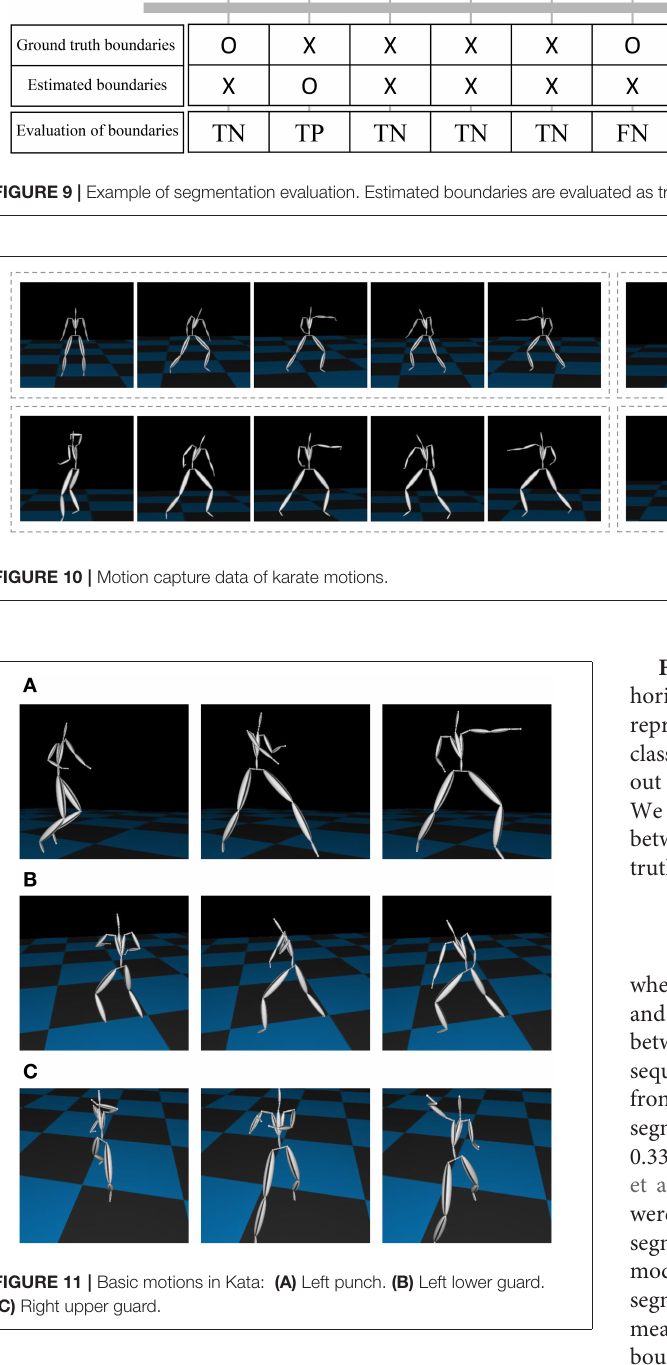
( x lh , y lh , x rh , y rh , x lf , y lf , x rf , y rf ). Because GP-HSMM requires